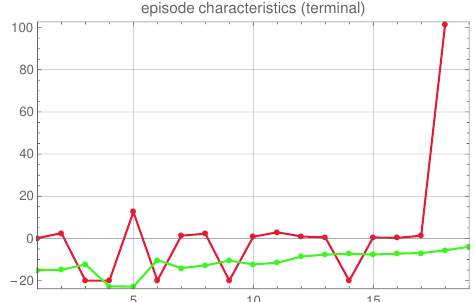
(a) Intrinsic value (green) and reward (red) vs episode steps. Figure 2. Characteristics of the episode connecting the states (4.5) and